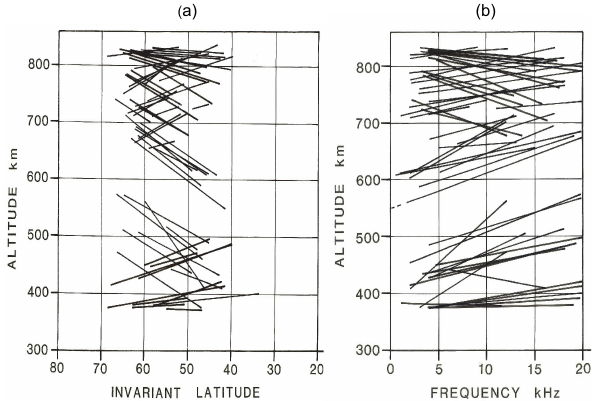
Figure 7 Morioka et al. Fig. 7. Altitude distribution of the LHR band emissions with respect to invariant latitudes ( a ) and frequencies ( b ) . Straight lines in each panel show intervals between the beginning and end of